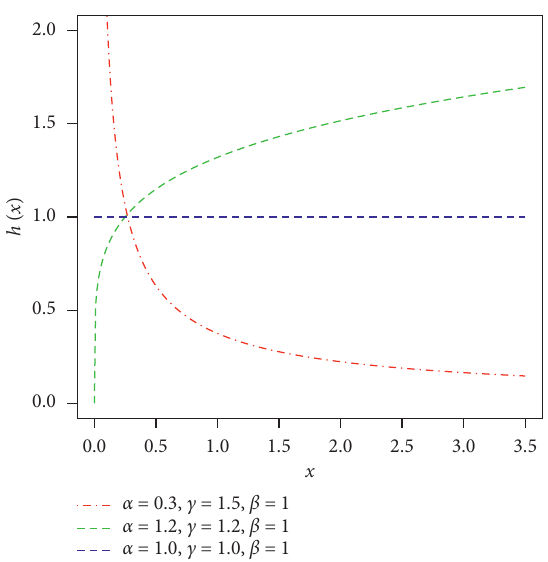
Figure 3: Graphical sketching of the HTBPT–Weibull hrf for some parameter